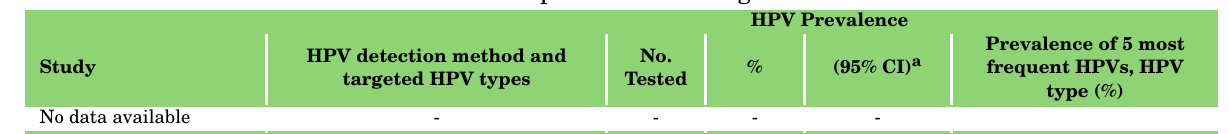
Table 28: Studies on HPV prevalence among VIN 2/3 cases in Peru